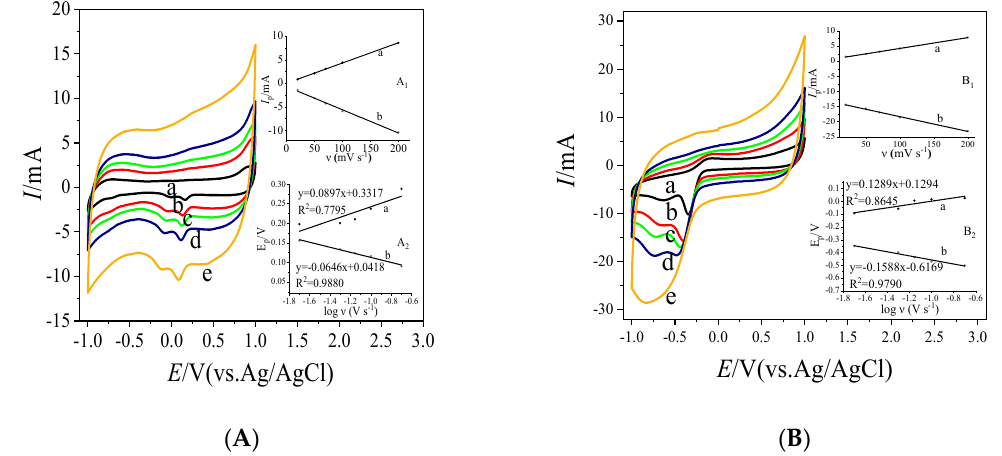
Figure 6. ( A ) CV of MC-GOx at di ff erent scan rates (20 mV s − 1 (a), 50 mV s − 1 (b), 70 mV s − 1 (c), 100 mV s − 1 (d), 200 mV s − 1 (e)), insets (A 1 and A 2 ) are plots of anodic and cathodic peak currents vs. scan rate and peak potentials vs. log scan rates respectively. ( B ) CV of COOH-MC-GOx at di ff erent scan rates (20 mV s − 1 (a), 50 mV s − 1 (b), 70 mV s − 1 (c), 100 mV s − 1 (d), 200 mV s − 1 (e)), insets (B 1 and B 2 ) are plots of anodic and cathodic peak currents vs. scan rate and peak potentials vs. log scan rates